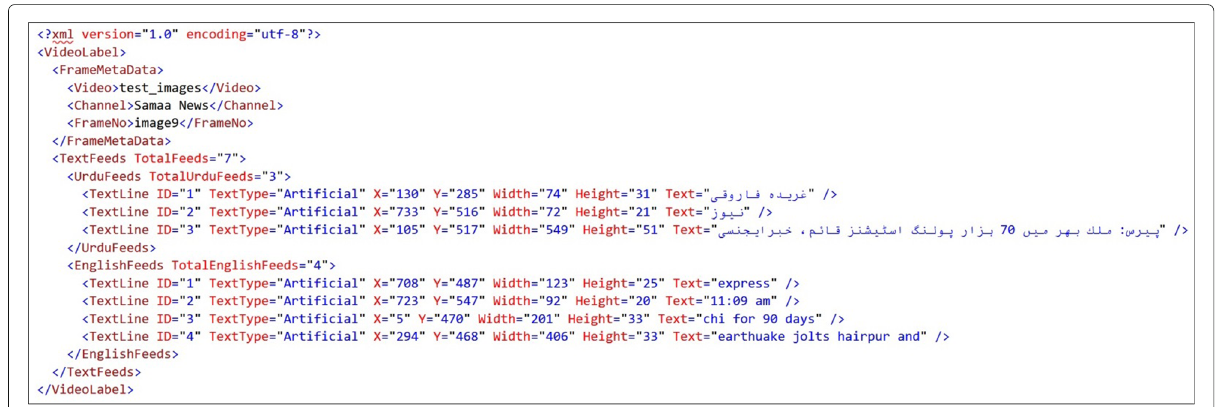
Fig. 5 Ground truth information of a labeled frame in an XML file